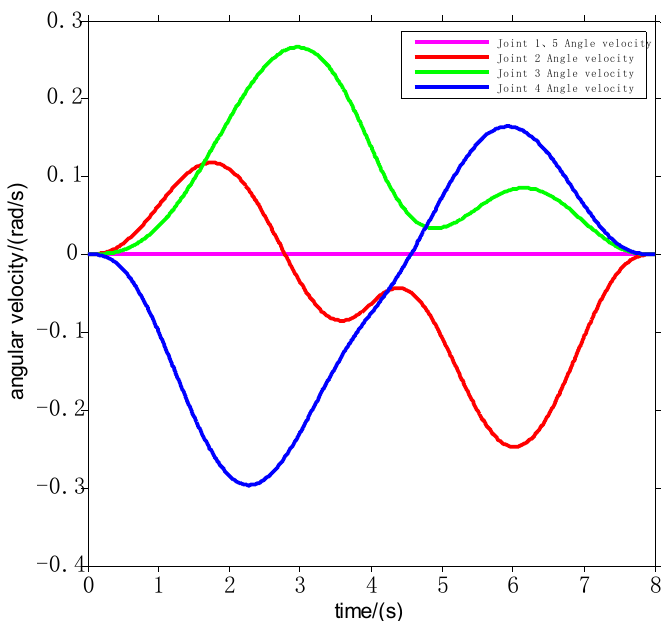
Figure 10. Spatial angular velocity of the robot joint.